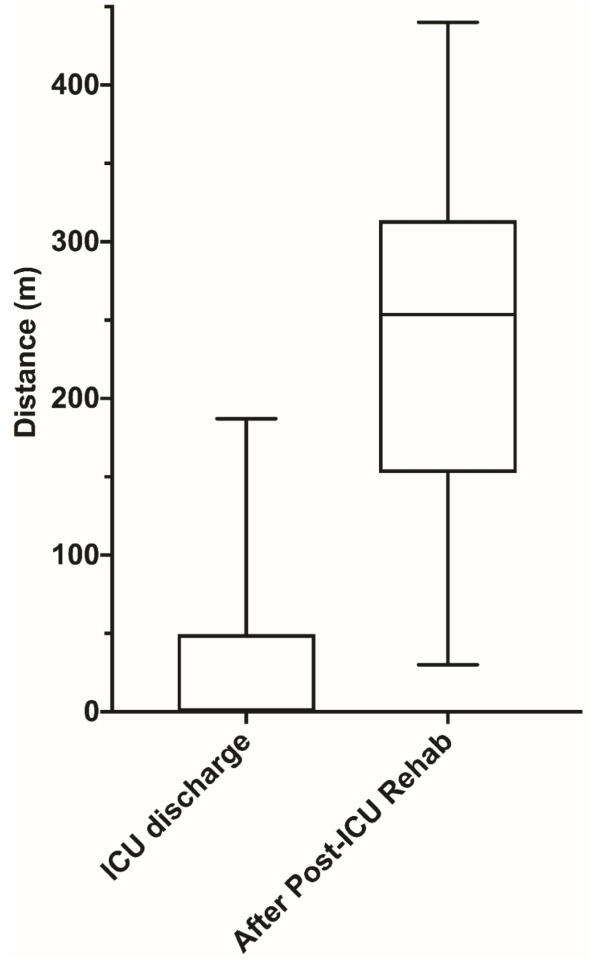
Figure 2. Evolution of the six-minute walking test distance between the day of ICU discharge and the last day in the post-ICU weaning and intensive rehabilitation